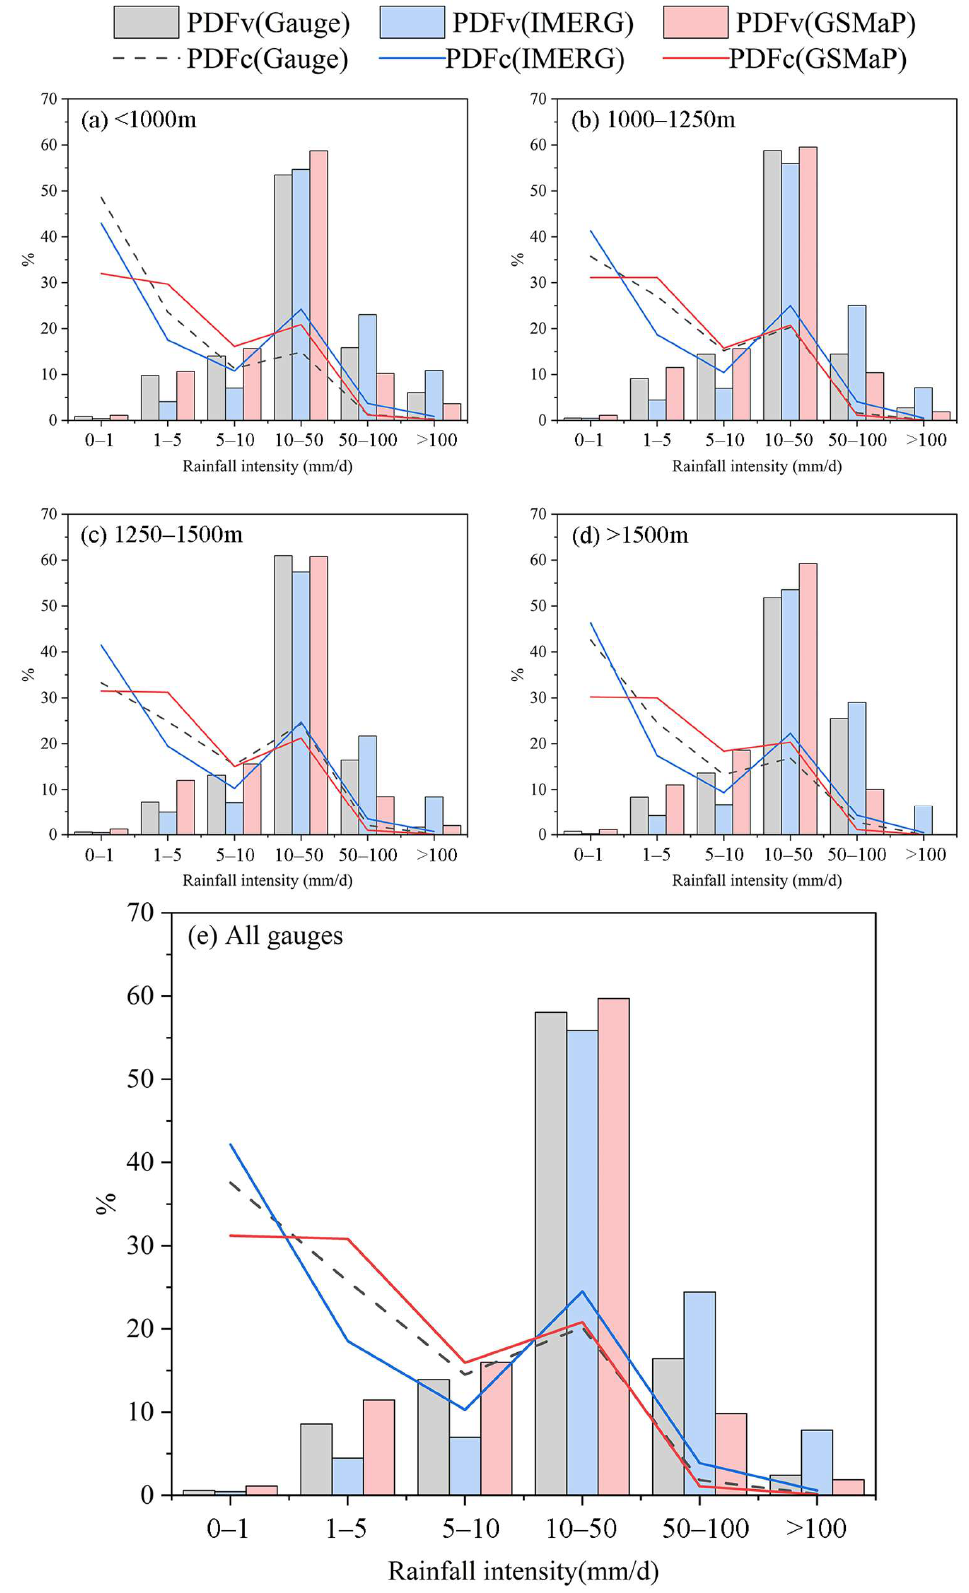
Figure 8. Occurrence probability distribution functions (PDFc) and volume probability distribution functions (PDFv) of rainfall estimates from IMERG, GSMaP and rain gauges over different elevation ranges with different rainfall intensities.